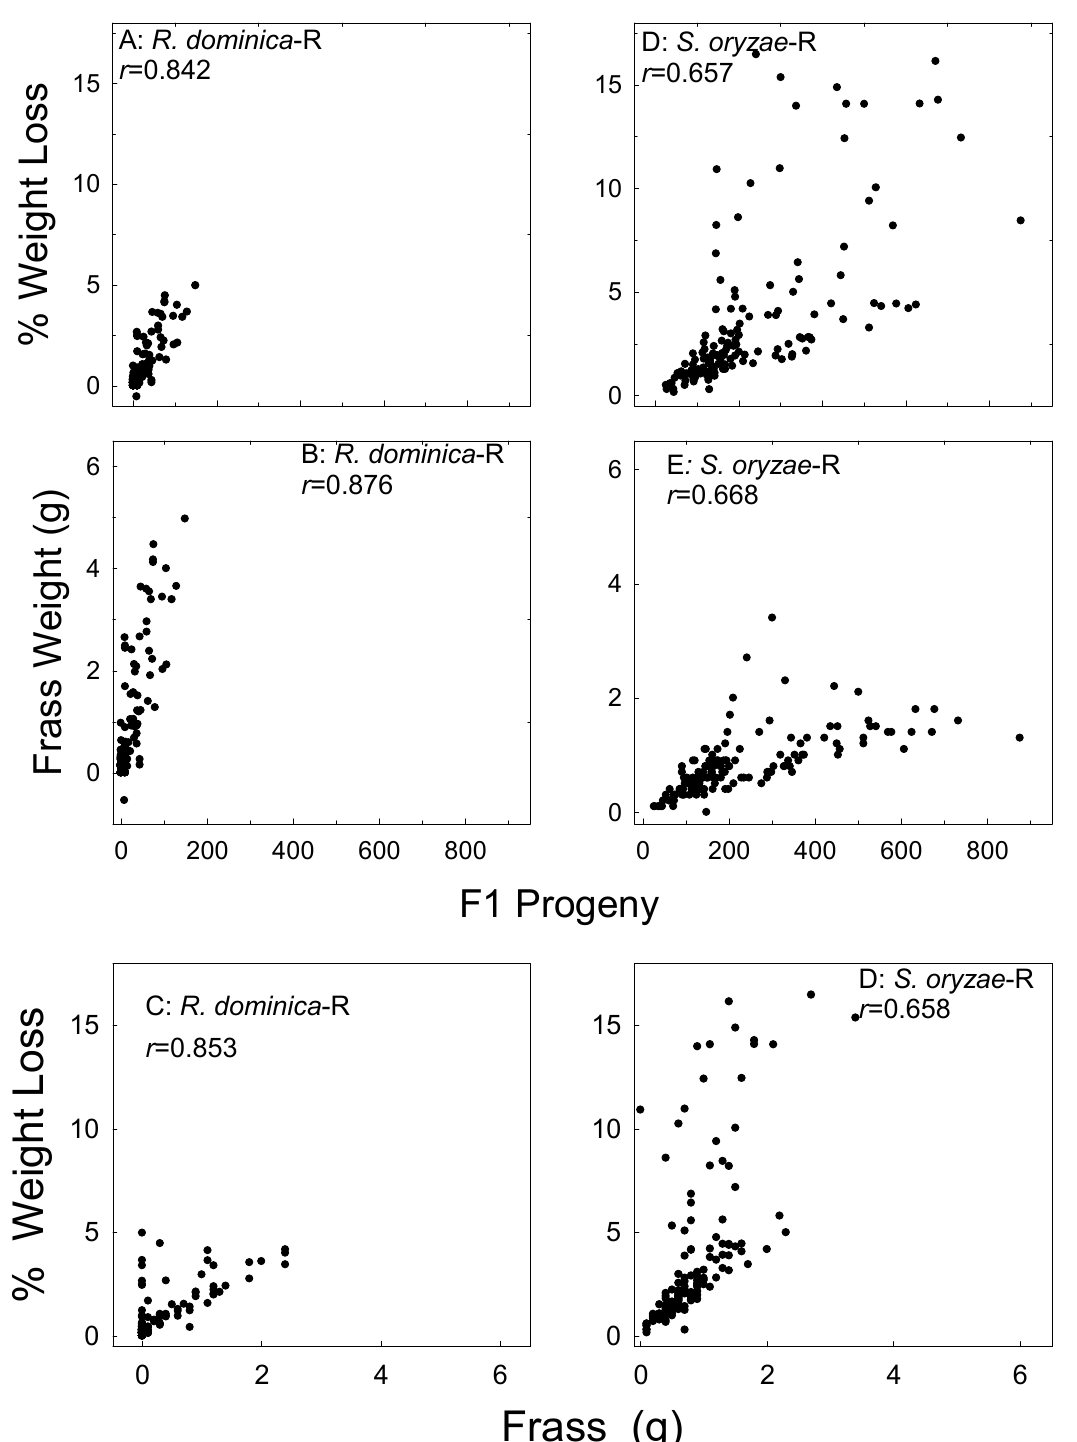
Figure 9. Correlation of brown rice (R) sample weight loss and frass weight with F 1 progeny of R. dominica ( A , B ), sample weight loss with frass weight ( C ), sample weight loss and frass weight with F 1 progeny of S. oryzae ( D , E ), and sample weight loss with frass weight ( F ). Data for the two parental exposure regimes combined, data for all treatments and all bioassay months combined.